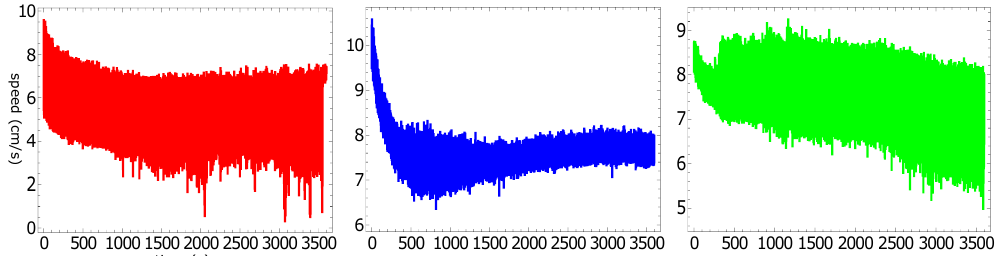
Figure 11. The radial distribution function of the positions of pill centers calculated from the distances illustrated in Figure 10. The same color is used to draw the radial distribution function and the trajectory.